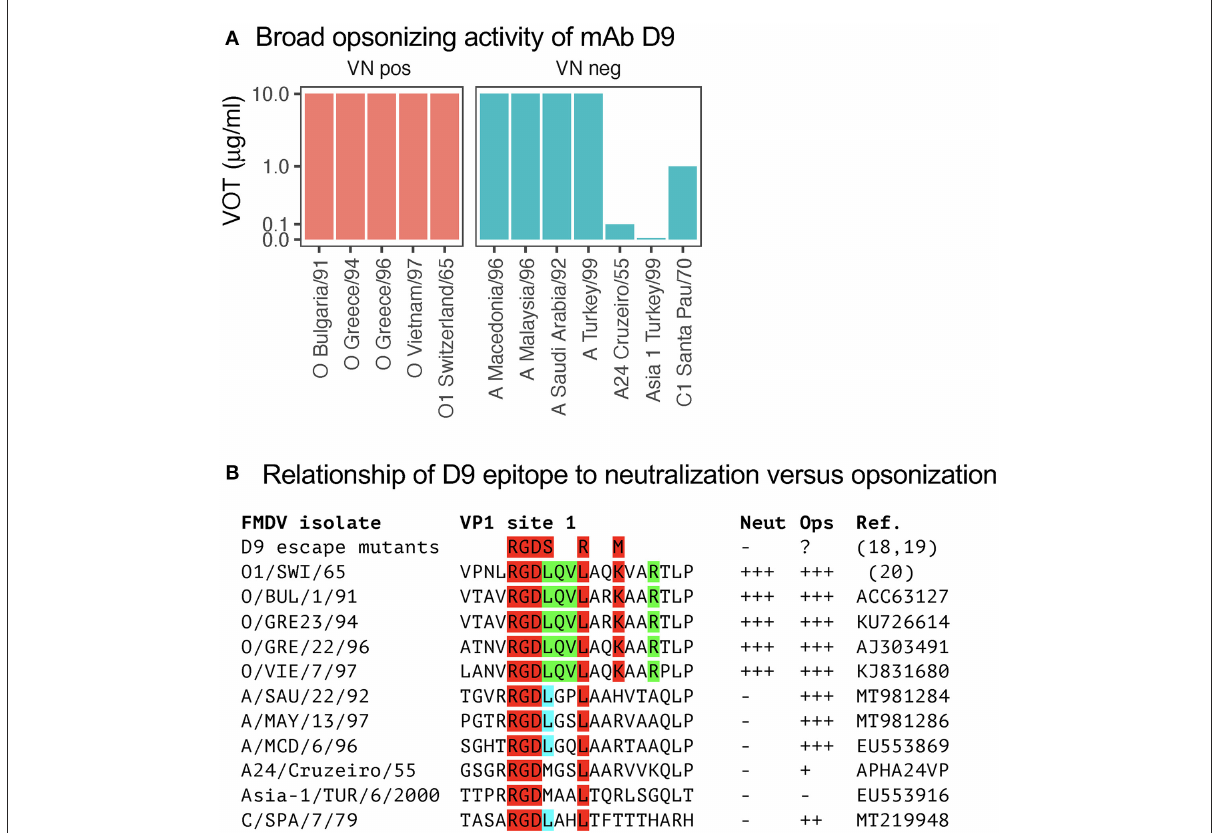
FIGURE3 Virus opsonizing titers of mAb D9 against heterologous serotypes and its epitope relationship. In (A) , VOTs were determined as for Figure 1 but included viruses from the A, Asia-1, and C serotypes of FMDV. The data was separated by the ability of a specific mAb to neutralize the different FMDV viruses tested in neutralization negative mAb-virus pairs (right panels in blue, “VN neg”) and neutralization positive mAb-virus pairs (left panels in red, “VN pos”). In (B) , the amino acid sequences of the D9 epitope from the viruses used in (A) are shown together with their neutralizing and opsonizing activities. The amino acids depicted in red and green are common to all viruses neutralized by D9. The leucine depicted in blue is found in all viruses that are well opsonized by